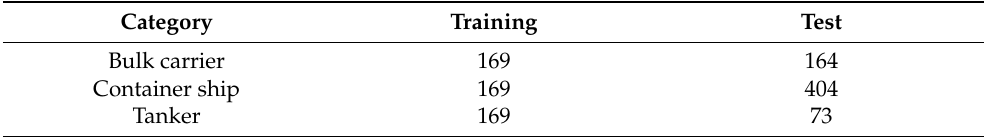
Table 2. Three-Category